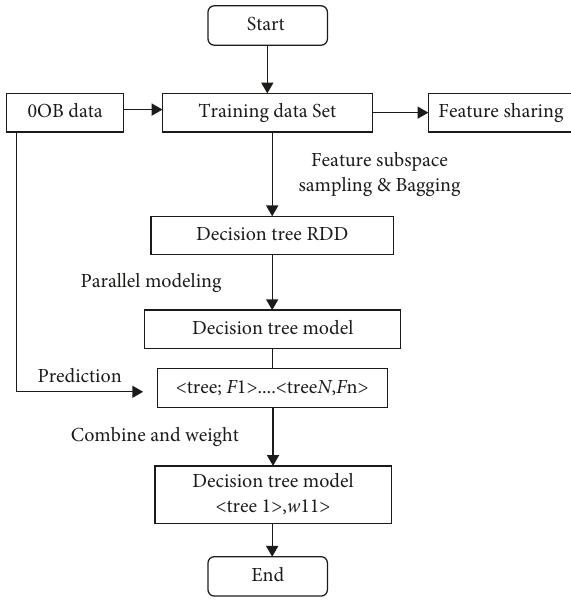
Figure 1: Computing framework of the random forest graph.